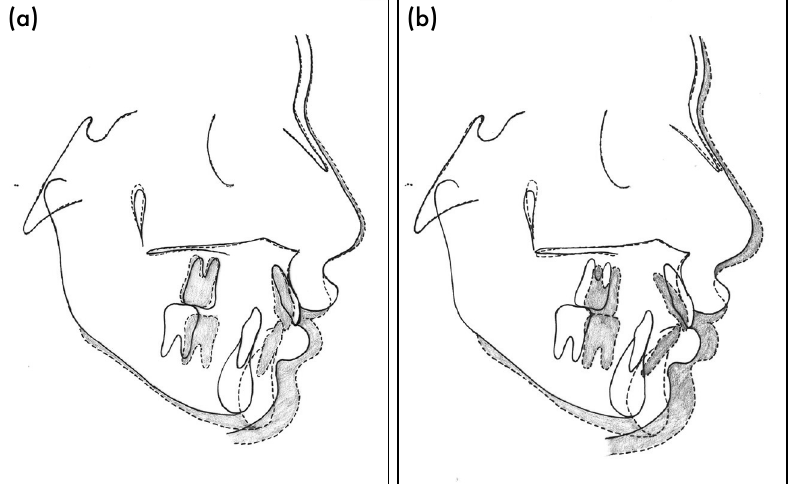
Figure 8. Superimposition of the lateral cephalograms at different stages. (a) Pretreatment (solid line) and post-functional (dashed line). (b) Pretreatment (solid line) and 1 year post-treatment (dashed